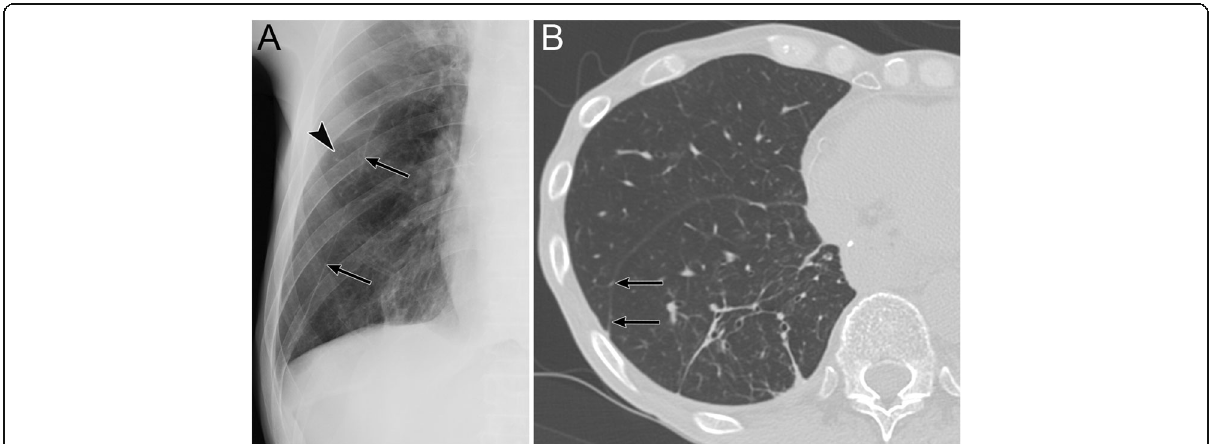
Fig. 9 The major fissure mimicking pneumothorax on a radiograph in a 71-year-old man. He underwent partial resection of the right S6 for lung metastasis of esophageal cancer. a The major fissure appears as a thick linear opacity (black arrows) in the right lung field on a supine radiograph. It resembles the visceral pleura in pneumothorax. Unlike pneumothorax, vascular markings (black arrowhead) are visible outside of the thickened fissure. b An axial CT image shows the major fissure extending in the anteroposterior direction with a slight oblique angle (black arrows). Some volume loss in the right lower lobe caused the fissure to be displaced posteriorly; therefore, it seems to be visible on the anteroposterior radiograph